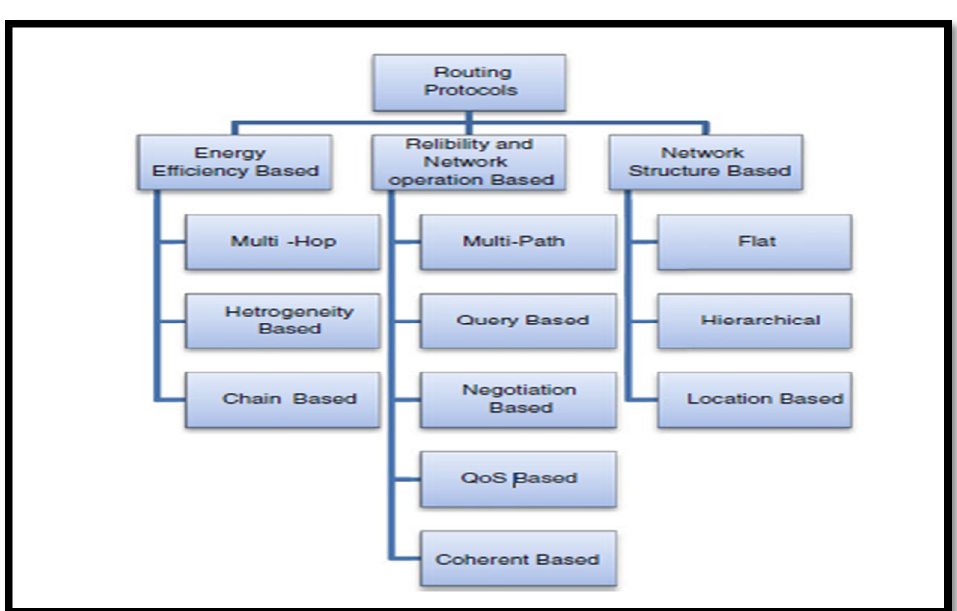
Fig. 1. Components of WSNs Node[3].